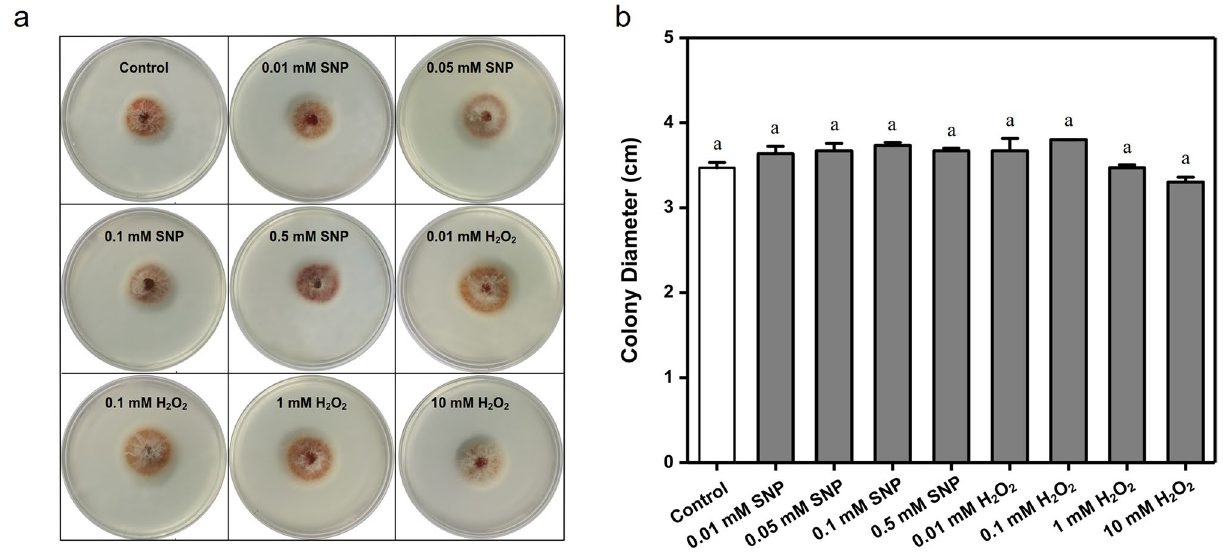
Figure 7. Colonies morphology and diameters of Shiraia bambusicola S4201 on different treatments. ( a ) Colonies morphology; ( b ) Diameter sizes. Values are the means of five independent experiments ± SE. Different letters on the histogram indicate significant differences between treatments ( p <